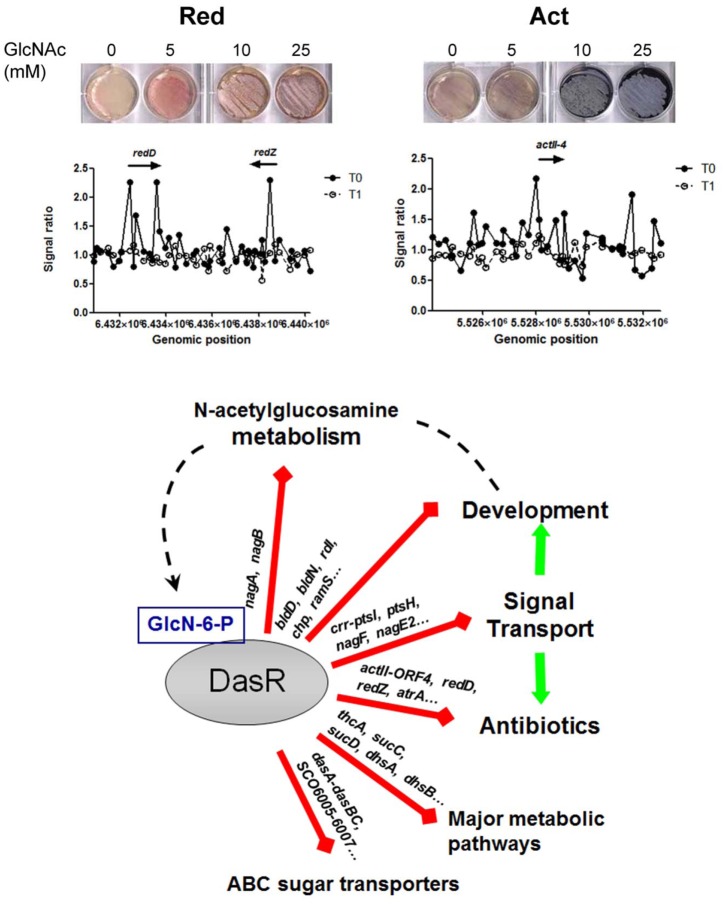
Model of the DasR regulon and its induction by N-acetylglucosamine.
Top: induction of development (grey pigment) and Red (left; red pigment) or Act (right; blue pigment) production on MM agar plates with increasing concentrations of N-acetylglucosamine; the S. coelicolor actII-ORF4 (M510) and redD (M511) mutants [76] were used to demonstrate the production of only the red-pigmented undecylprodigiosin or the blue-pigmented actinorhodin, respectively. Middle, corresponding ChIP-chip experiments showing relief of DasR binding from the act and red regulatory genes in vivo after the addition of GlcNAc (examples taken from Fig 2). T0 (closed circles) and T1 (open circles), time points before and 30 min after the addition of 25 mM GlcNAc; respectively. Bottom, summary of the DasR-controlled processes and major targets that are directly or indirectly controlled by DasR. Red lines indicate direct binding and transcriptional repression of the target genes by DasR (for some developmental genes only based on ChIP-on-chip data). Derepression of control by DasR in response to the accumulation of GlcN-6P results in activation (green lines) of morphological development and antibiotic production, among other processes.